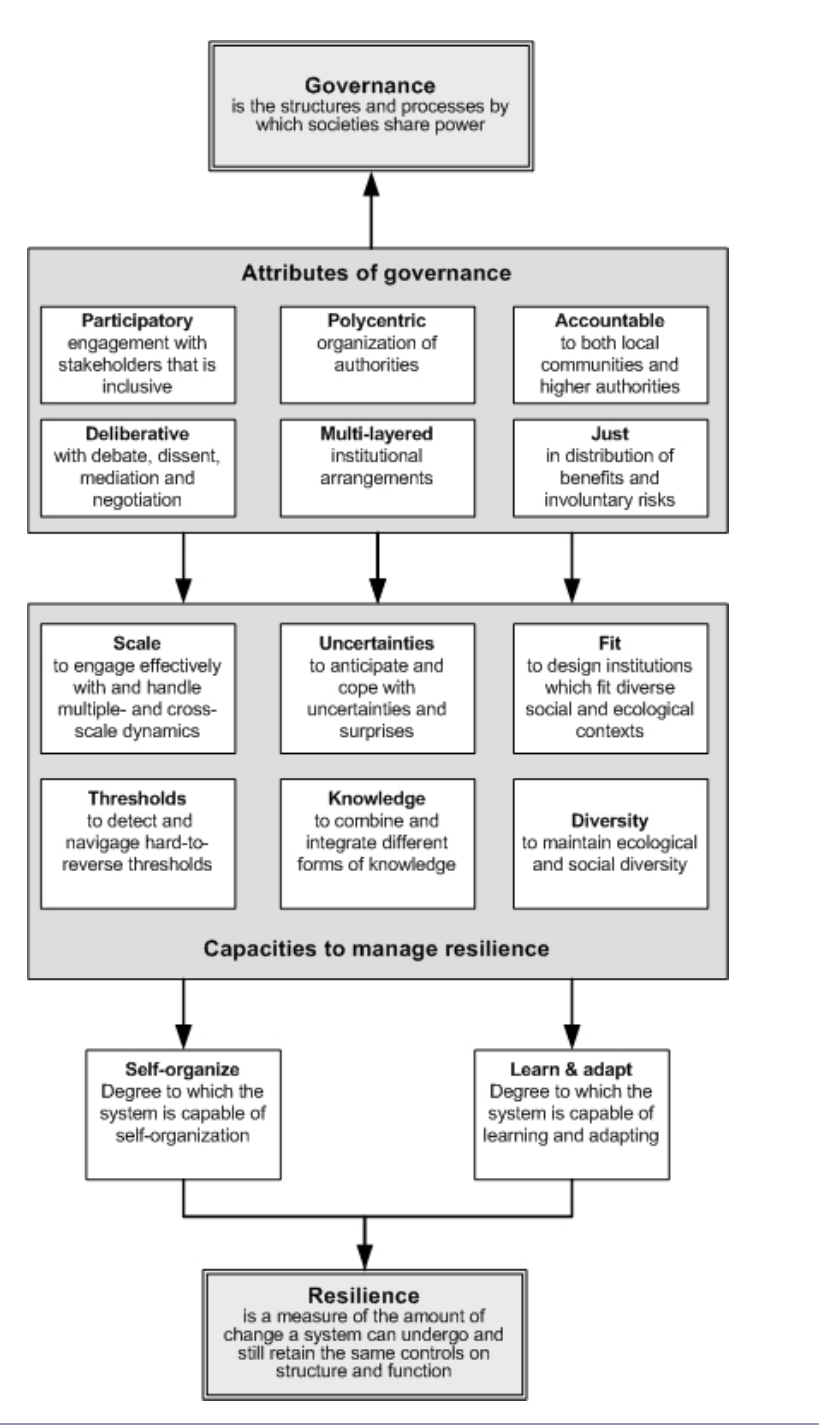
Fig. 1 . Associations between selected attributes of governance systems and the capacity to manage